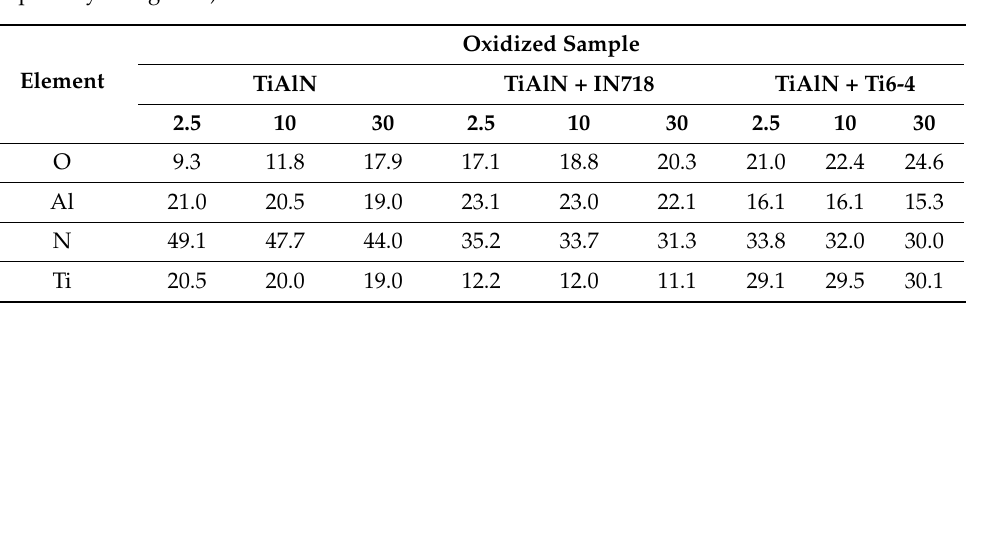
Table 3. The estimated chemical composition of oxidized layers deposited at 900 ◦ C (presented graphically in Figure